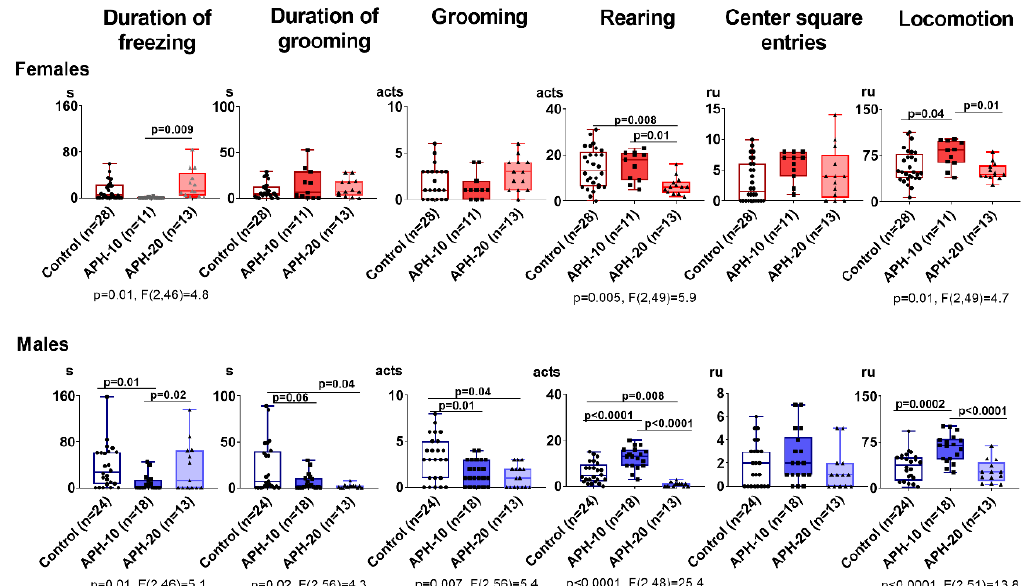
Figure 1. Influence of acute prenatal hypoxia on behavioral parameters of the adult female and male offspring. Behavioral parameters indicated above the graphs are presented as mean ± SEM, expressed in seconds (s) (duration of freezing and grooming), acts (number of grooming, rearing) or relative units (ru) (center square entries, locomotion). Significance of the differences between the two indicated groups is shown on the graphs as p -values, estimated by using one-way ANOVA with Tukey’s post hoc test. For the parameters with significant ( p < 0.05) differences, the p -values and F-statistics of one-way ANOVA are shown below the graphs. n —the number of rats in each group. 2.2. Only APH-10 Affects ECG, with the ECG Changes Similar in the Female and Male